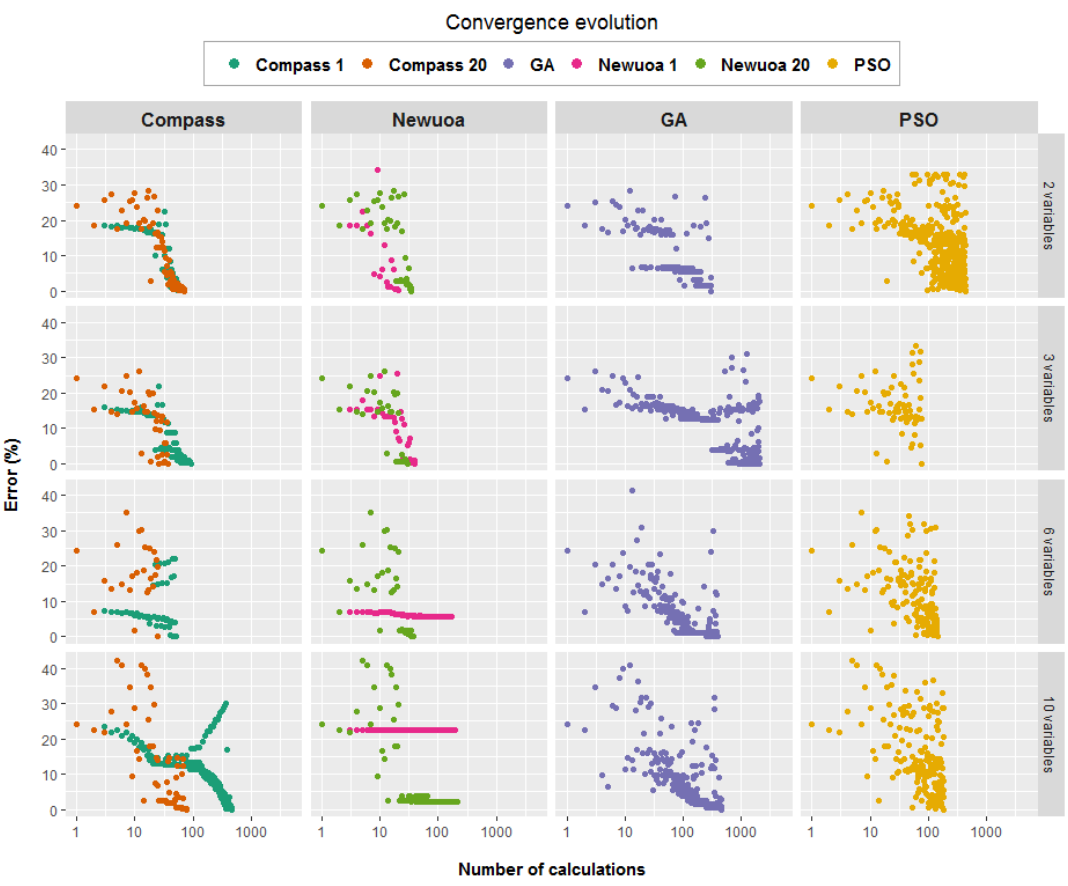
Figure 8. Convergence evolution.